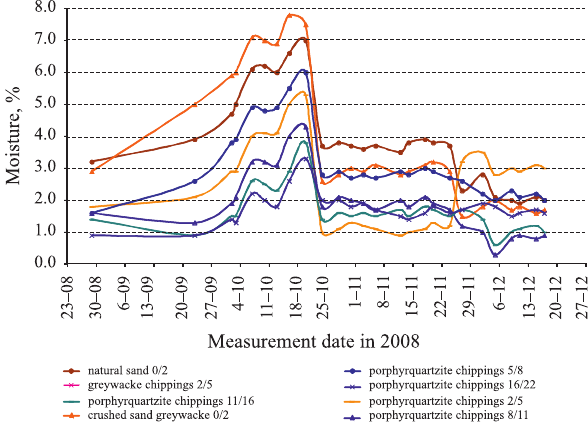
Fig. 2. The aggregate moisture content on the plant site in the AMP Benninghoven in 2008